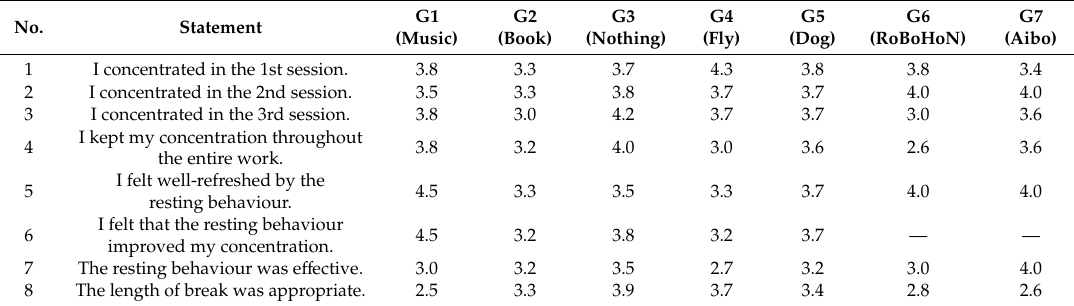
Table 2. Average scores in the